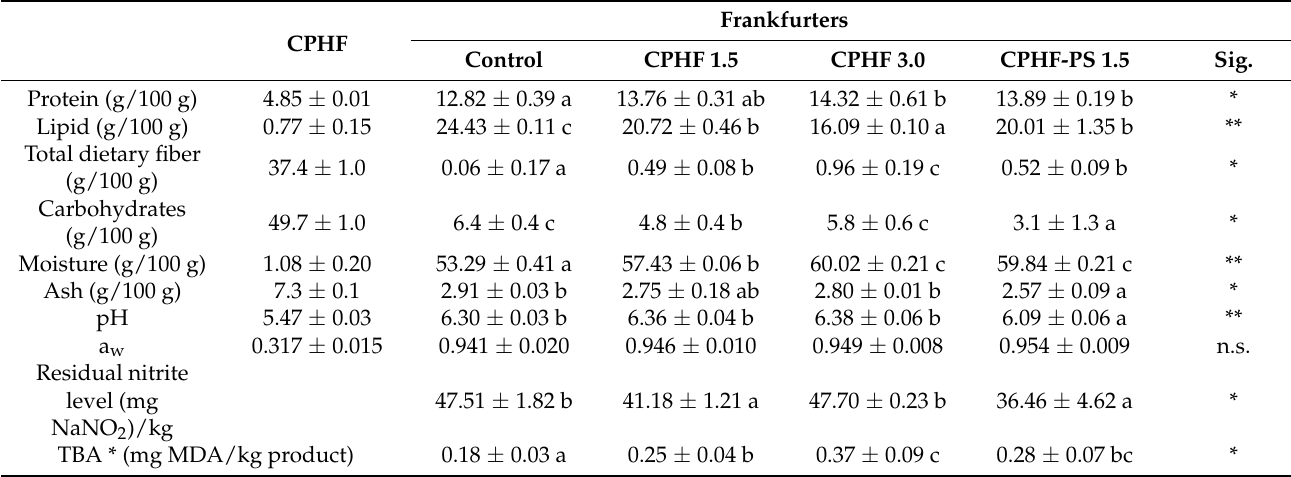
Table 2. Proximate composition (g/100 g sample), TBA value, residual nitrite level, pH, and a w of cacao pod husk and